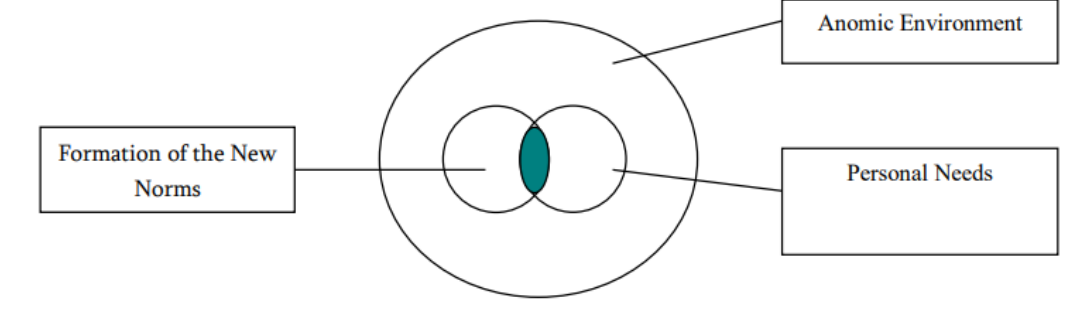
Figure 4. Interdependence of the Environmental and Personal